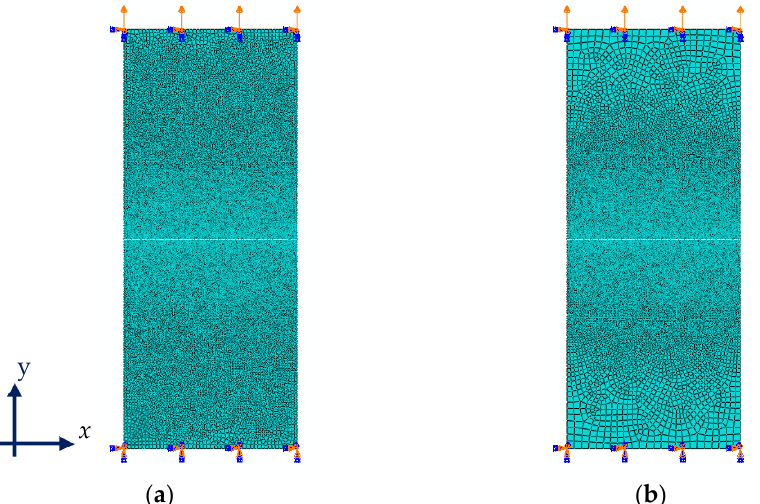
Table 3. Geometry details of the laminate. Figure 1. Boundary conditions and random mesh discretization of ( a ) plain and ( b ) center cracked laminates.